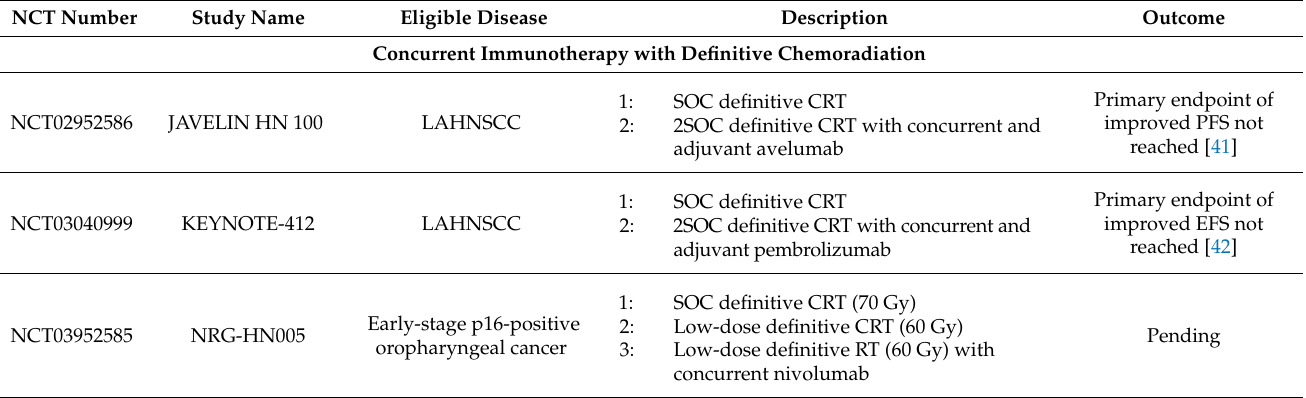
Table 2. Selected Phase III clinical trials of immunochemoradiation in locally advanced head and neck